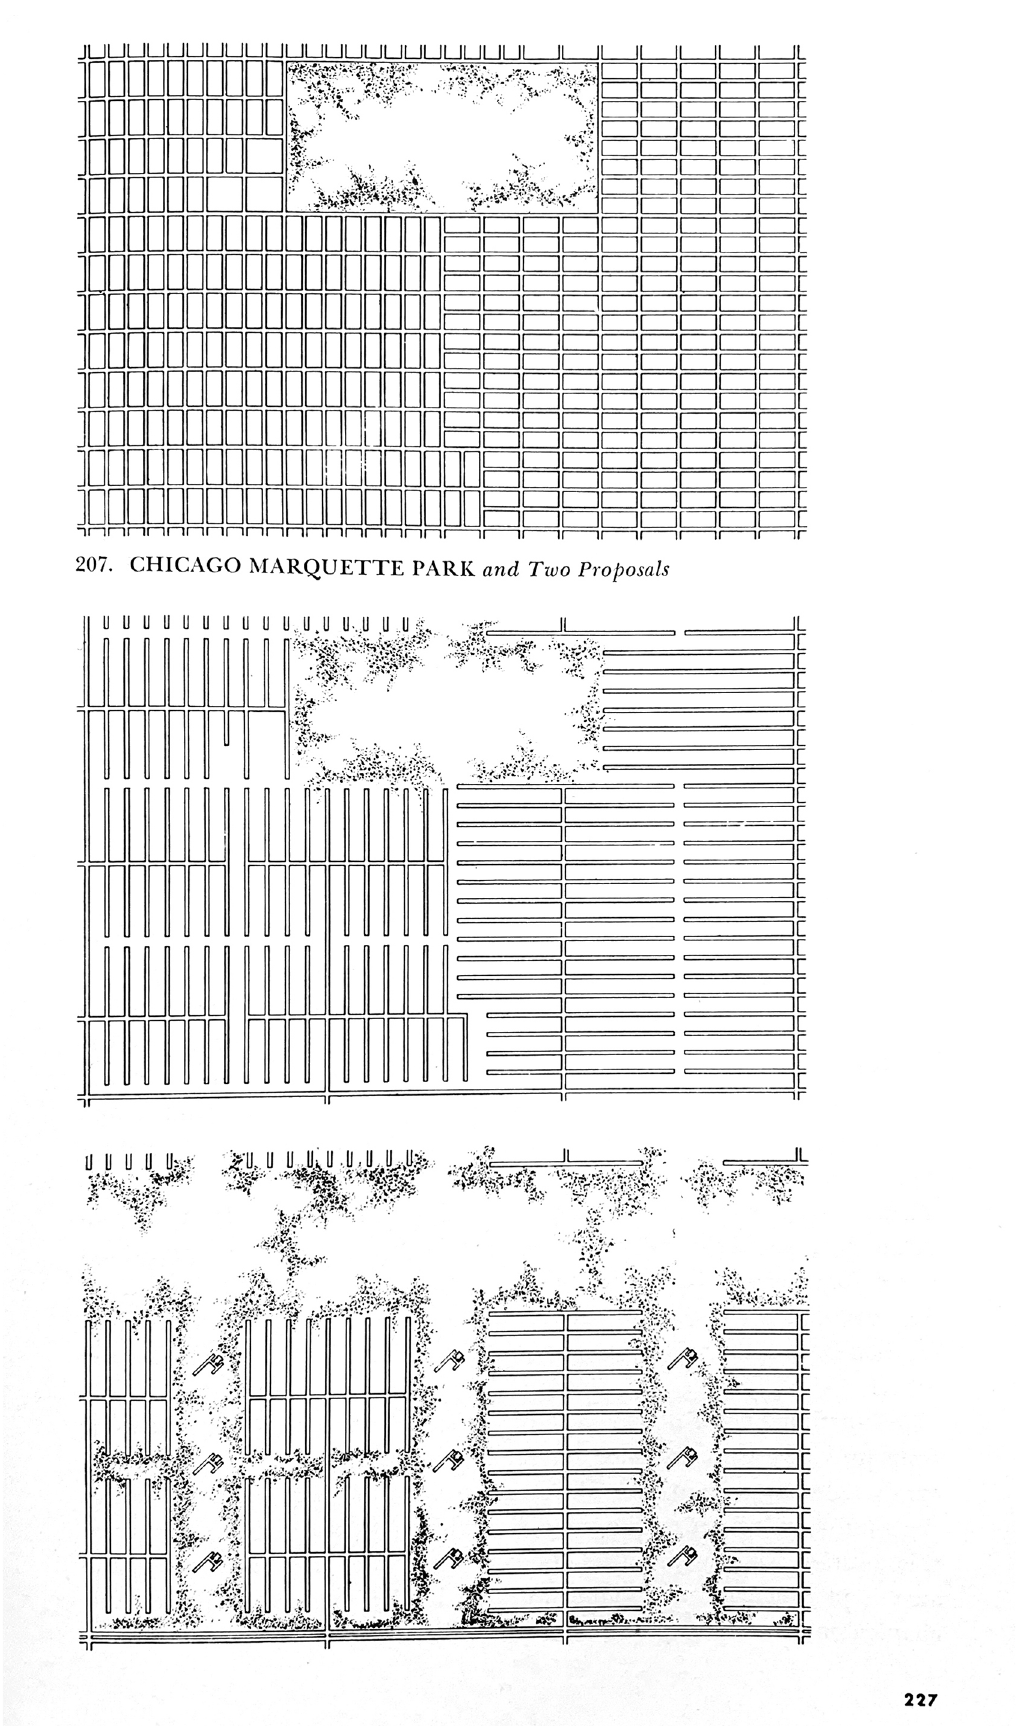
Figure 2. “Chicago Marquette Park and Two Proposals,” 1955. Source: Hilberseimer (1955a, p.